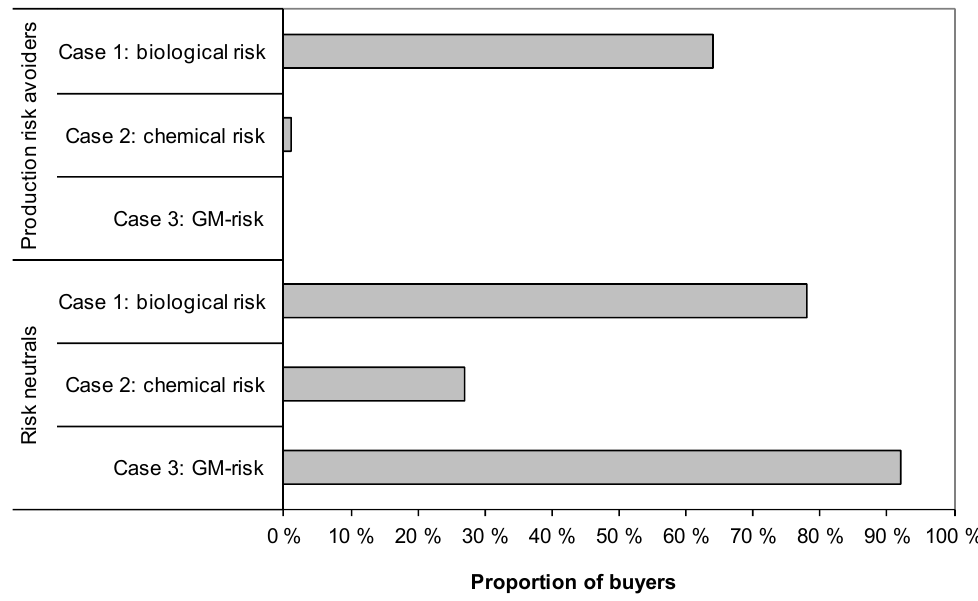
Figure 1. The stated intention to buy risk products in two consumer classes based on latent class logistic